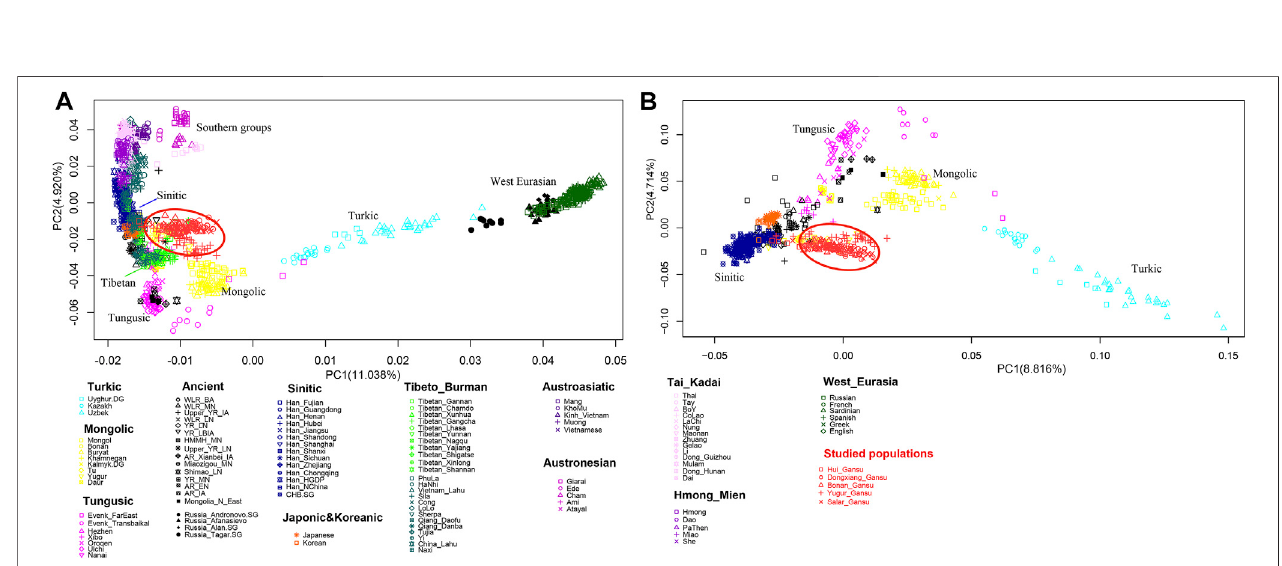
FIGURE 2 | The results of ROH calculation. (A) the length distribution; (B) the average length.